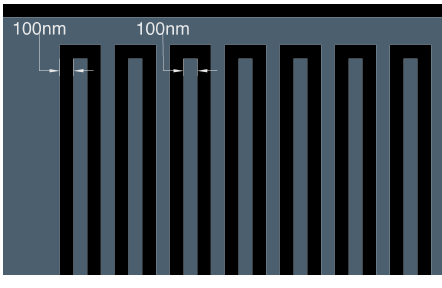
Figure 17. Nanowire prototype fabricated by the AnaBHEL Collaboration, shown here through the autoCAD zoom-in.